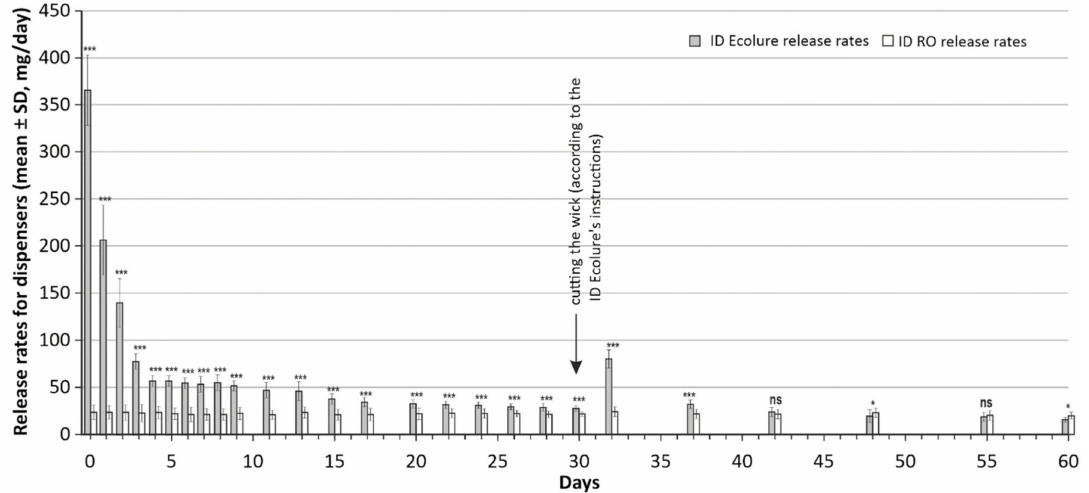
Figure 1. Comparison of release rates of ID Ecolure and ID RO dispenser types, obtained in laboratory conditions (20 ◦ C, RH = 50%). The symbols above the error bars indicate the significance of the differences between the release rates according to t -test (ns—not statistically significant ( p > 0.05); * significant ( p < 0.05); *** very highly significant ( p < 0.001)). Table 1. Relative abundances of selected active compounds, together with the presence of solvent and antioxidant in three types of freshly opened dispensers tested in 2017. Ratios of Id and EM are presented